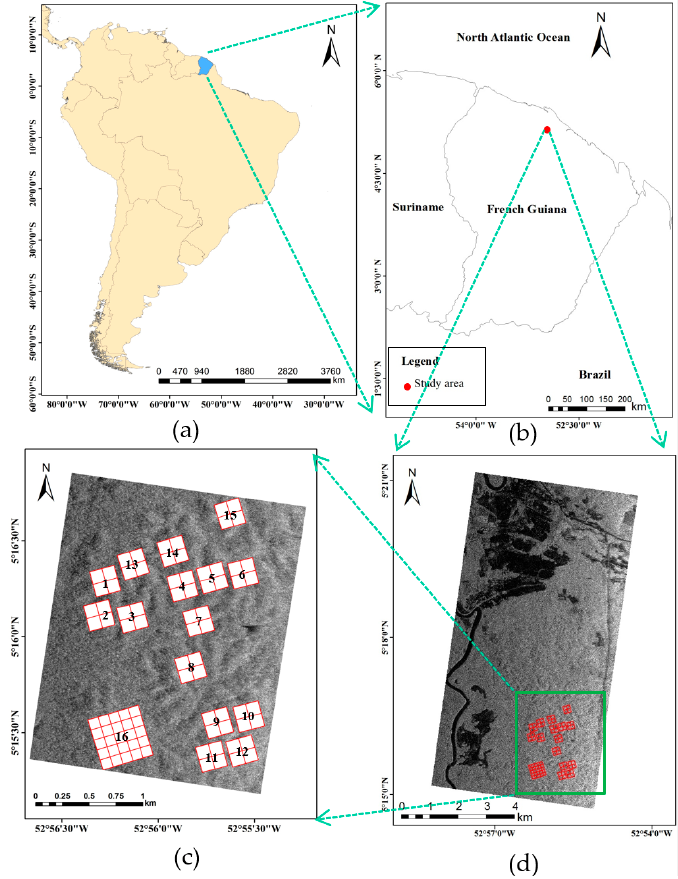
Figure 1. Overview of study area. The map ( a ) shows location of French Guiana in South America. The red dot in ( b ) map is the geographical location of the study area. In the ( d ) image, the base map on the right is synthetic aperture radar (SAR) (HV polarization) data and the green box over the SAR data is the study area, and the red boxes inside the study area are the sample plot locations. The ( c ) image shows the division strategy of 16 fixed plots.